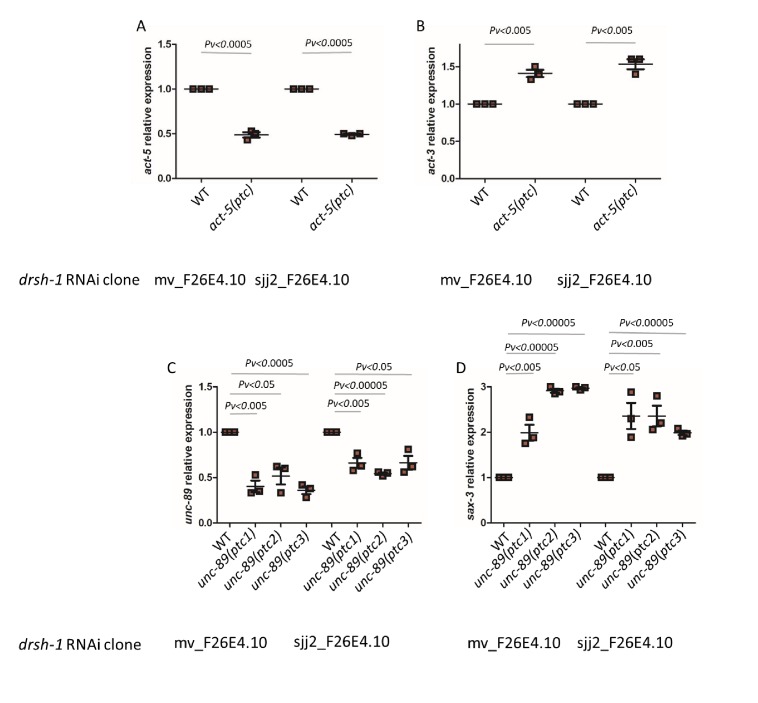
qPCR analysis of act-5 (A) and act-3 (B) mRNA levels in WT and act-5(ptc) mutants as well as of unc-89 (C) and sax-3 (D) mRNA levels in WT and unc-89(ptc) mutants upon drsh-1 RNAi-mediated knockdown by two independent clones.WT expression levels are set at 1. Data are mean ± S.E.M.; average dCt values are shown in Figure 4—source data 1. Two-tailed Student’s t-test was used to calculate P values.